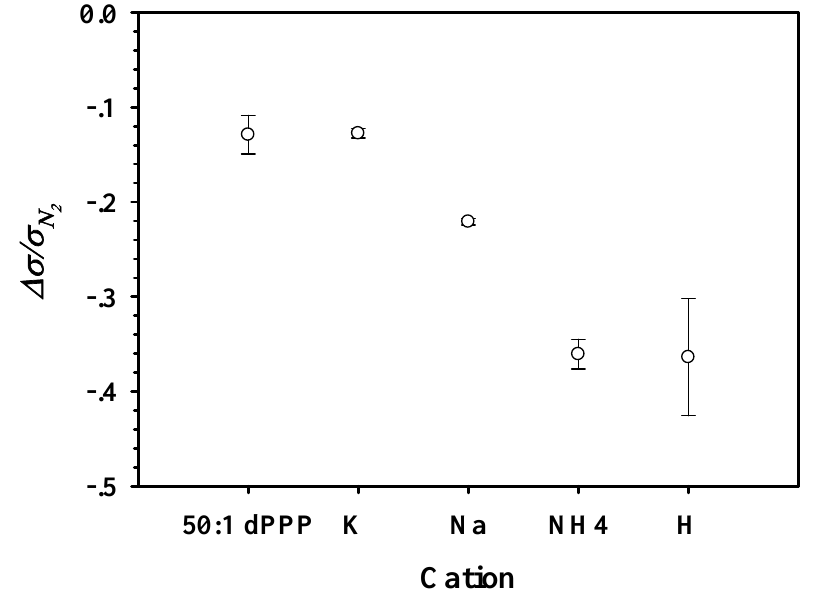
of 50:1 dPPP and 50:1 dPPP(90)/ZSM-5(23) composites of